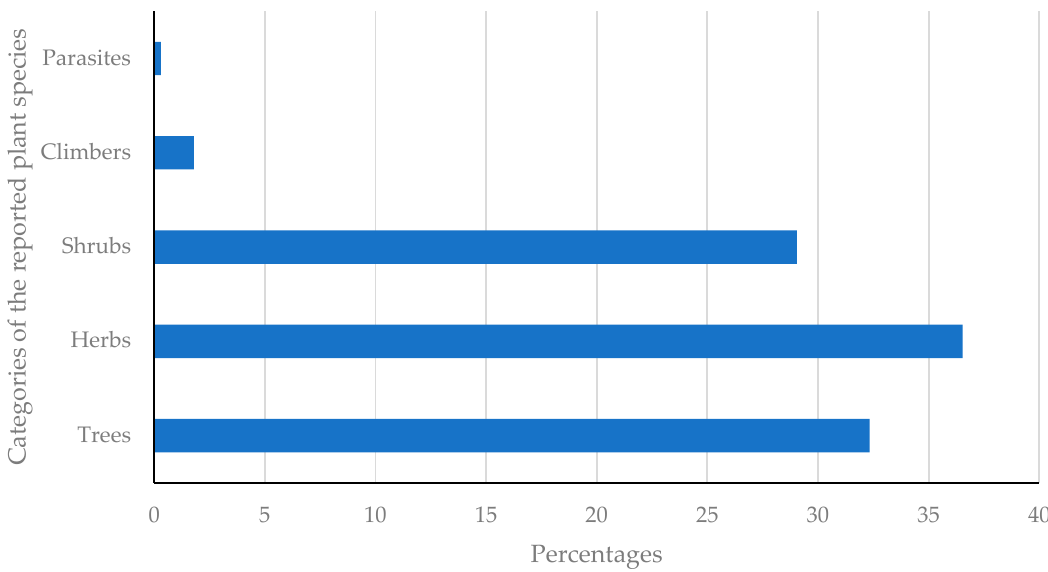
Figure 3. Percentages of the various categories of plants